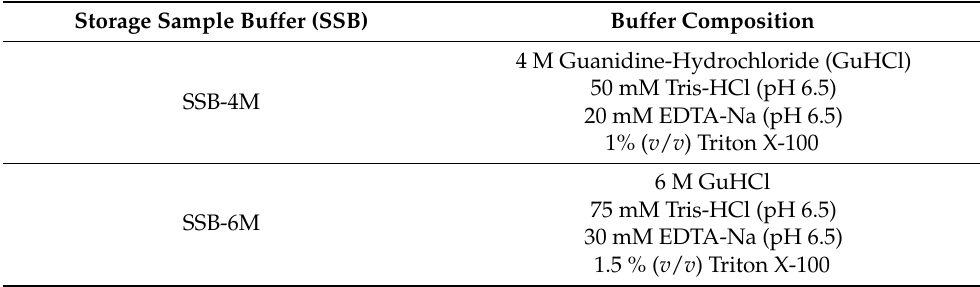
Table 1. Storage sample buffers and their chemical